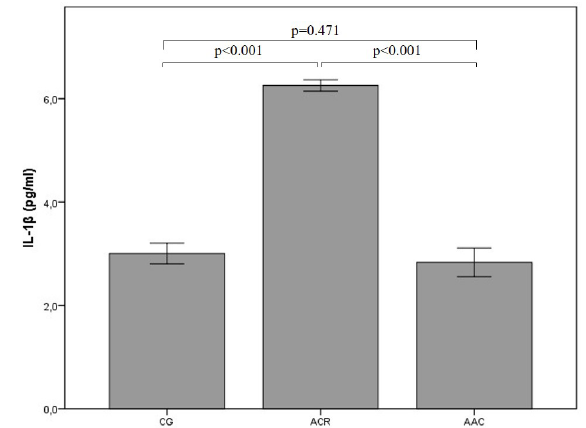
FIGURE 4 - Comparison of the IL-1β levels between the study groups. Bars represent mean ± standard deviation. CG control group, ACR acrylamide-treated group, AAC anakinra + acrylamide-treated group.